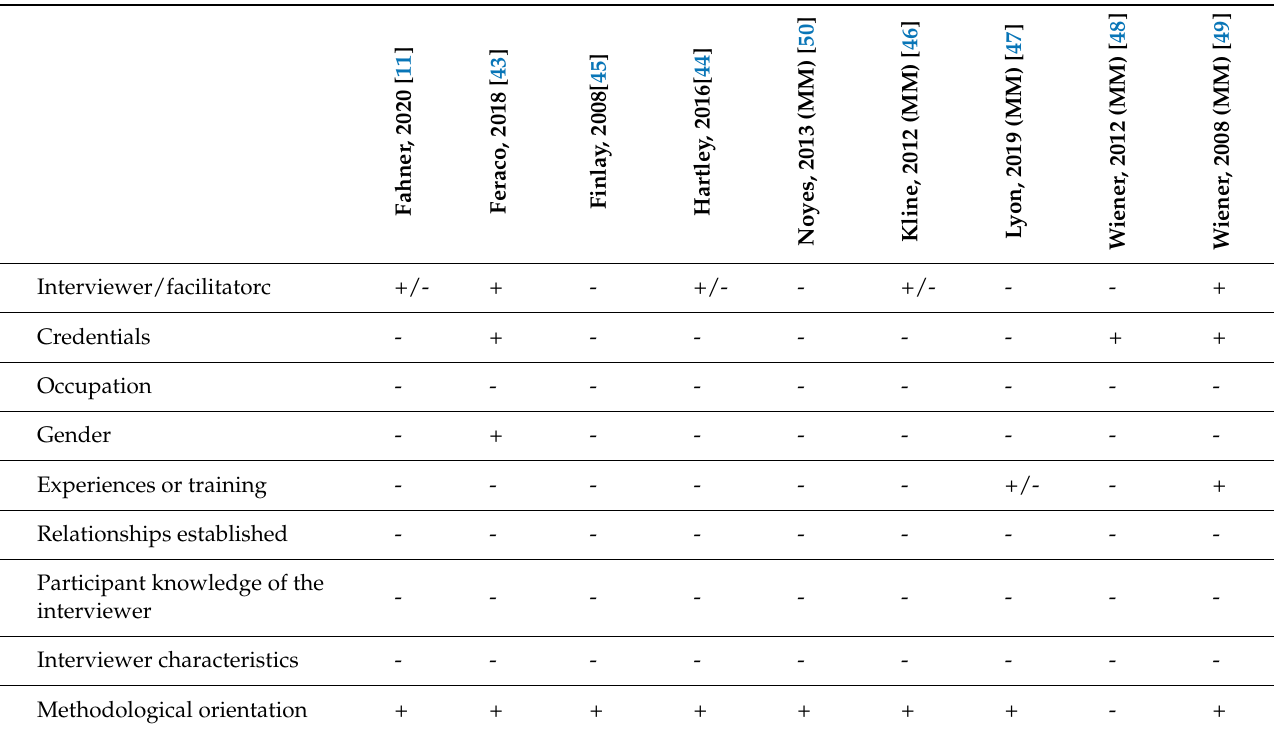
Table A3. Quality of reporting in qualitative studies according to the Comprehensive consolidated criteria for Reporting Qualitative